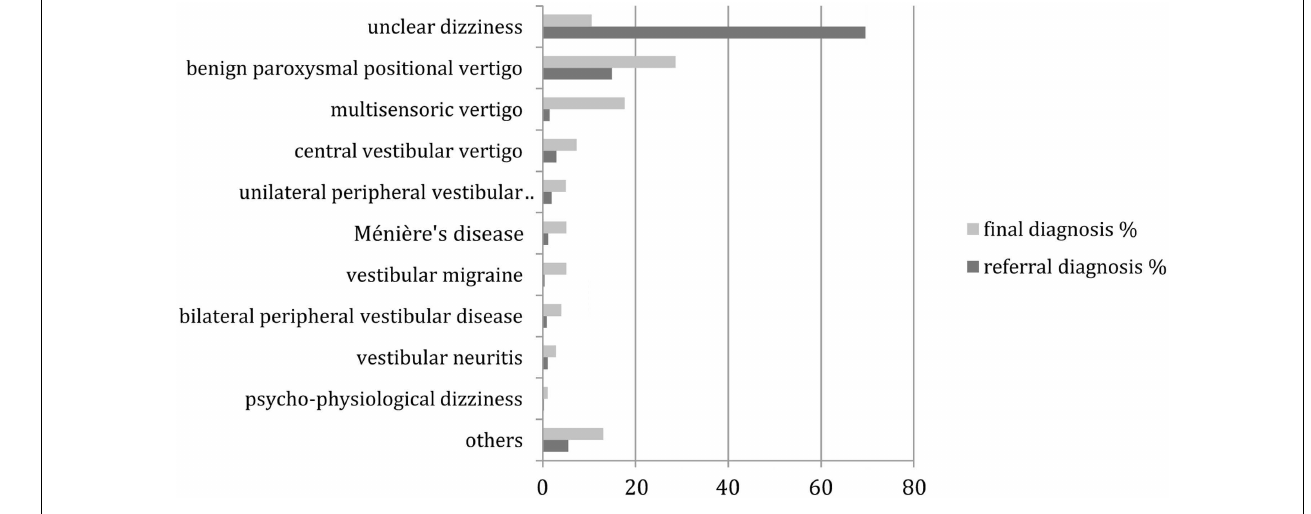
FIGURE 1 | Distribution of referral and final diagnoses in all patients. “Others” include presyncopal dizziness, perilymph fistula, ocular vertigo, afferent ataxia, dizziness after head trauma, vestibular paroxysmia,